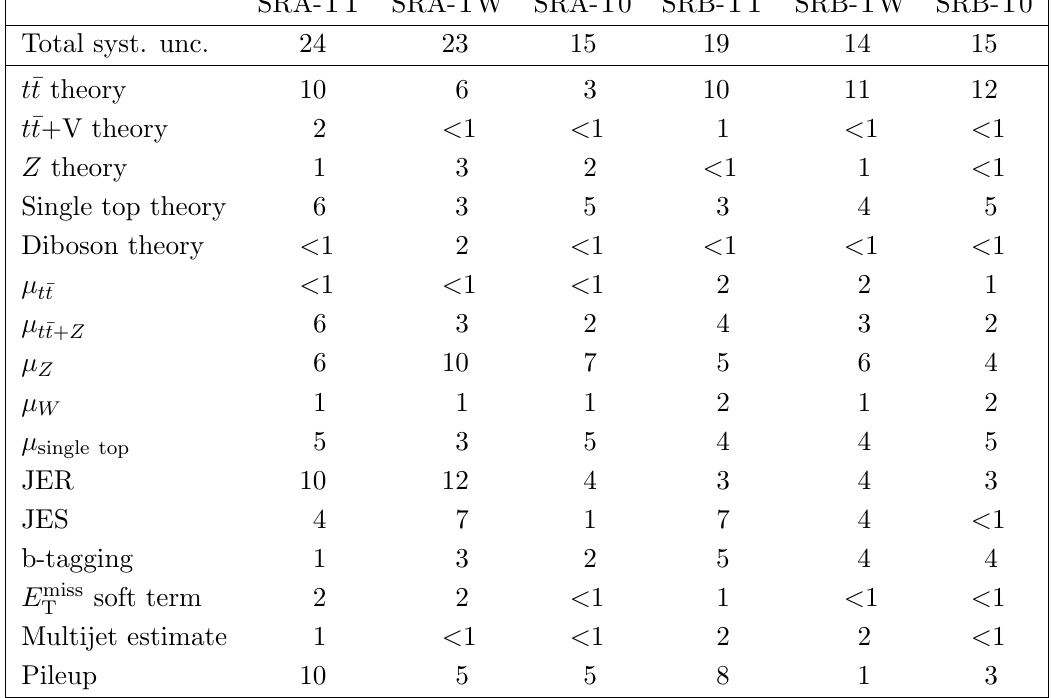
Table 9. Dominant systematic uncertainties (greater than 1% for at least one SR) for SRA and SRB in percent relative to the total background estimates. The uncertainties due to the normalization from a control region for a given signal region and background are indicated by (cid:22) t (cid:22) t (cid:22) W , and (cid:22) single top . The theory uncertainties are the total uncertainties for a given background. Additionally, the uncertainty due to the number of MC events in the background samples is shown as \MC